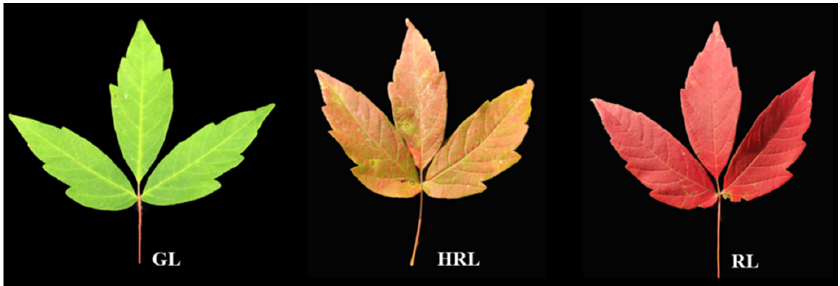
Figure 1. Different leaf color change stages of A. triflorum , green leaf (GL), orange (HRL), and red leaf (RL).